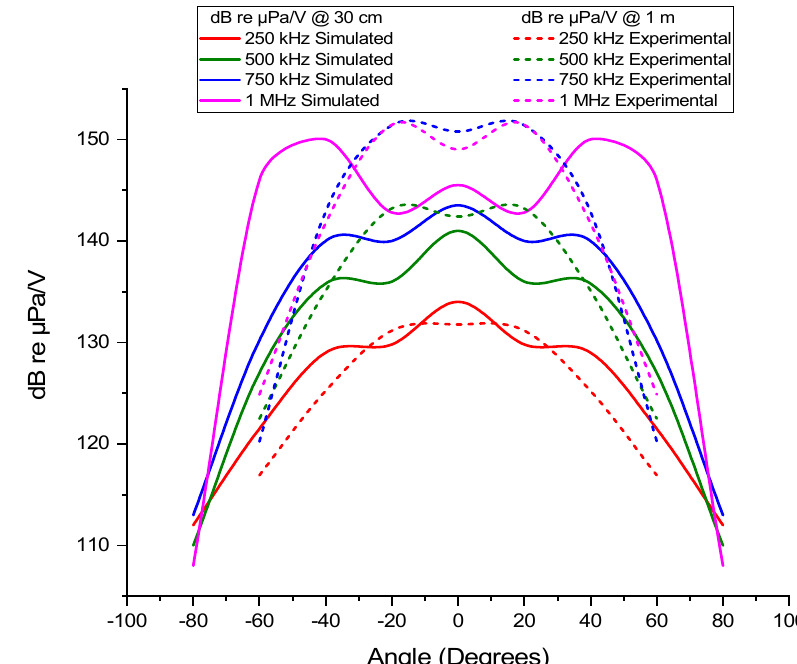
Figure 8. Experimental and simulated results of the unnormalized radiation diagram for 250 kHz, 500 kHz, 750 kHz, and 1 MHz frequencies. The dashed line corresponds to the experimental results (dB re µPa/V@1 m) and the continues line to the simulation results (dB re µPa/V@30 cm).